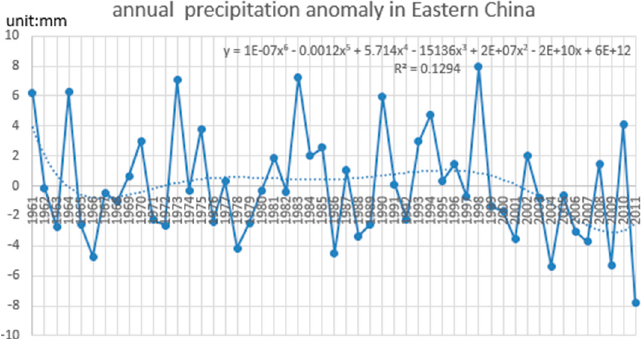
Figure 6. The inter-annual variability of average annual precipitation anomaly in eastern China from 1961 to 2011.